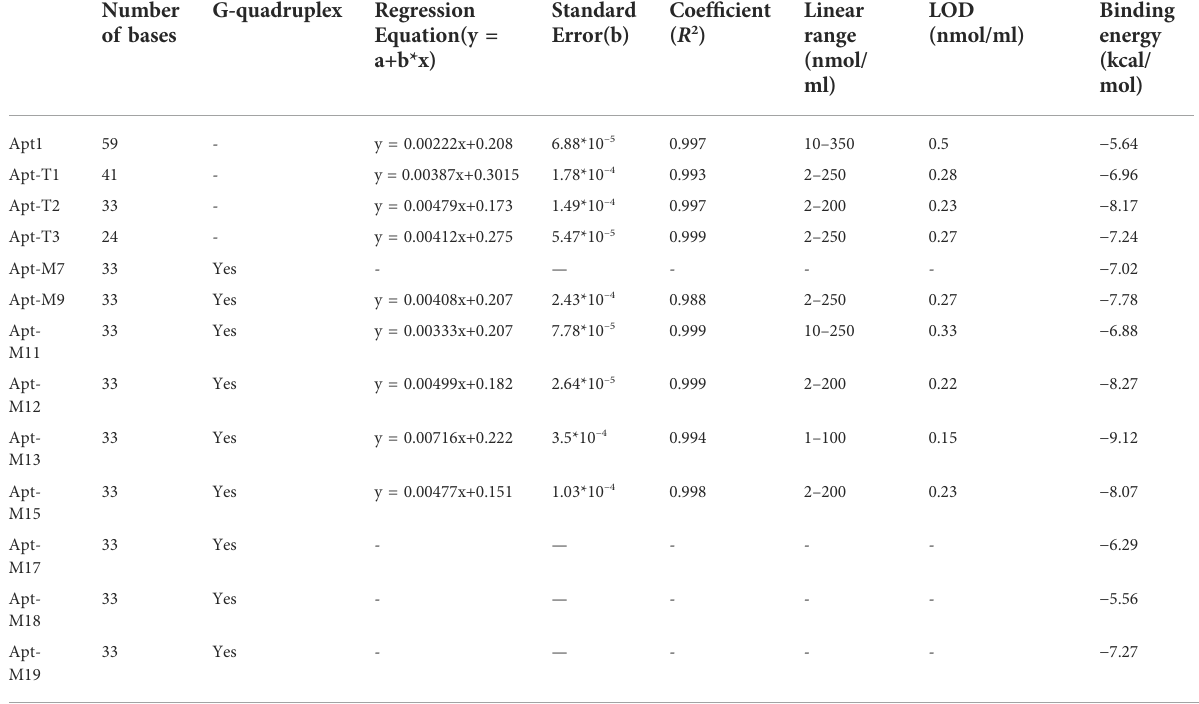
TABLE 1 Linear responses and molecular docking results of each